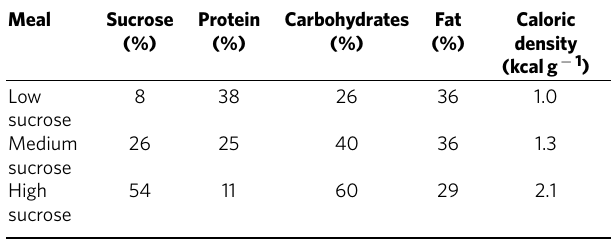
Table 3 | Macronutrient composition of meals used in the sucrose preference